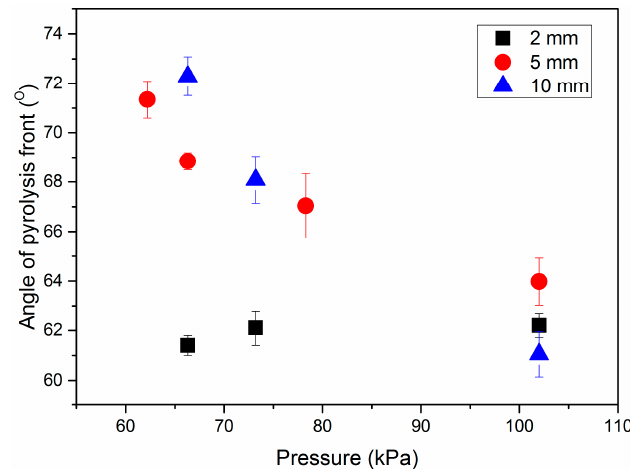
Figure 4. Angle of pyrolysis front ( α ) with respect to ambient pressure for different sample thicknesses ( δ